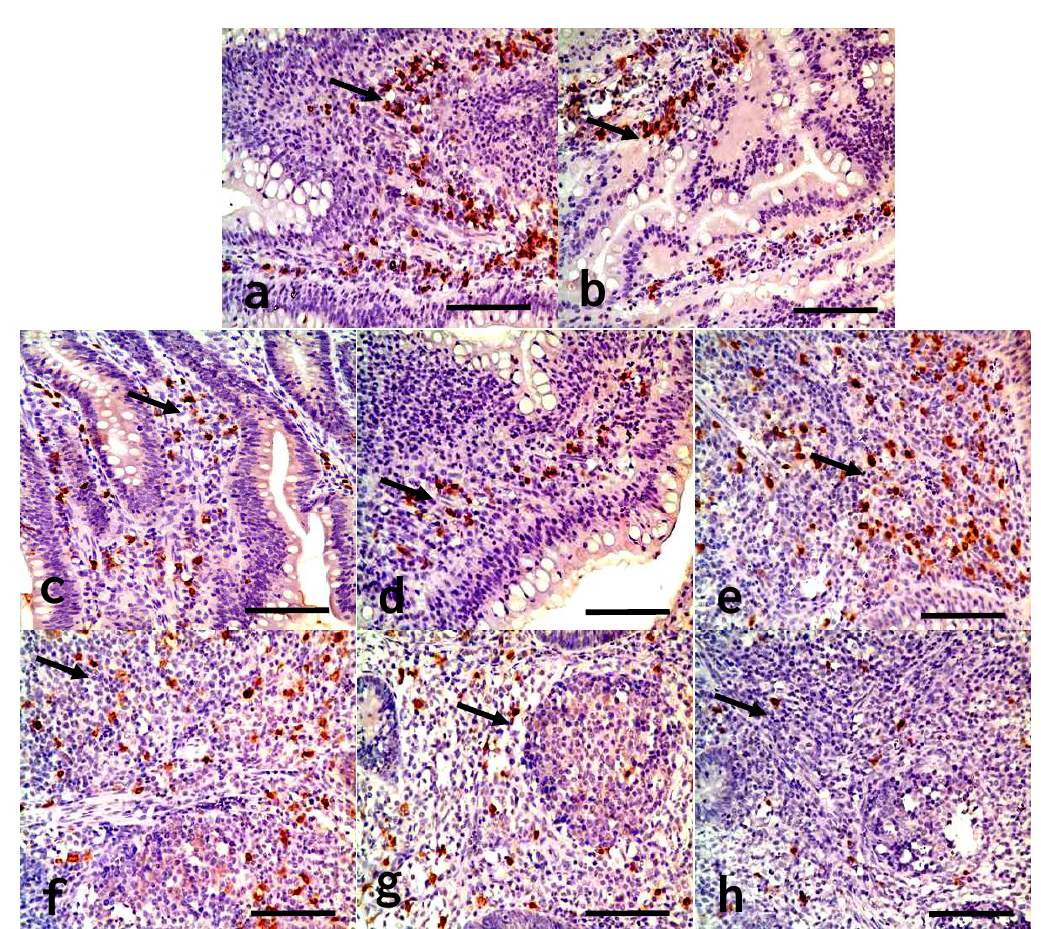
Figure 6. IgA + B cells in the lamina propria and the diffuse lymphoid tissues and lymphoid follicles of the cecal tonsil at 42 days of age. ( a ) The cecal tonsil in the control group. ( b ) The cecal tonsil in the 300 mg/kg group. ( c ) The cecal tonsil in the 600 mg/kg group. ( d ) The cecal tonsil in the 900 mg/kg group. ( e ) The cecal tonsil in the control group. ( f ) The cecal tonsil in the 300 mg/kg group. ( g ) The cecal tonsil in the 600 mg/kg group. ( h ) The cecal tonsil in the 900 mg/kg group. (SABC, bar = 50